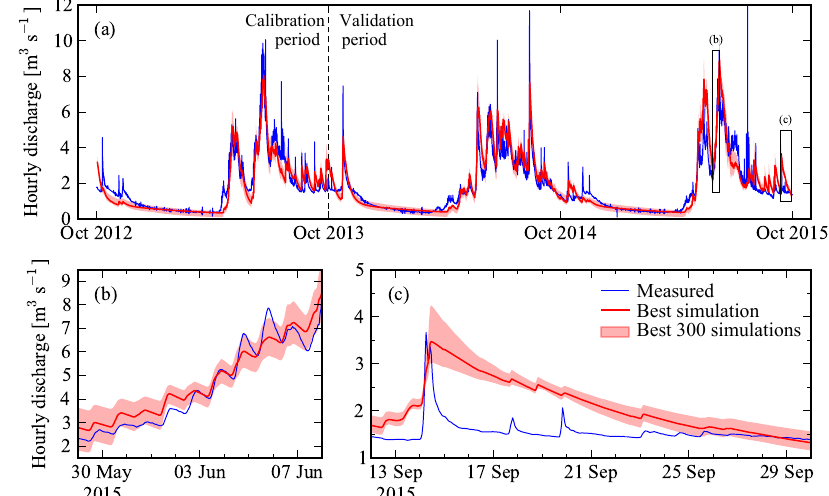
Figure 6. Comparison between the measured (blue line) and simulated (red line) time evolution of hourly mean discharge at the watershed outlet. Panel (a) pictures the entire simulated period, and panels (b) and (c) correspond to zooms on two selected time periods (their extents are indicated as black rectangles in panel a ). The simulated curve was obtained with StreamFlow configured so as to advect water in the stream channels using the instantaneous routing approach. The uncertainty range corresponds to the 300 best runs of the model out of the 10000 Monte Carlo